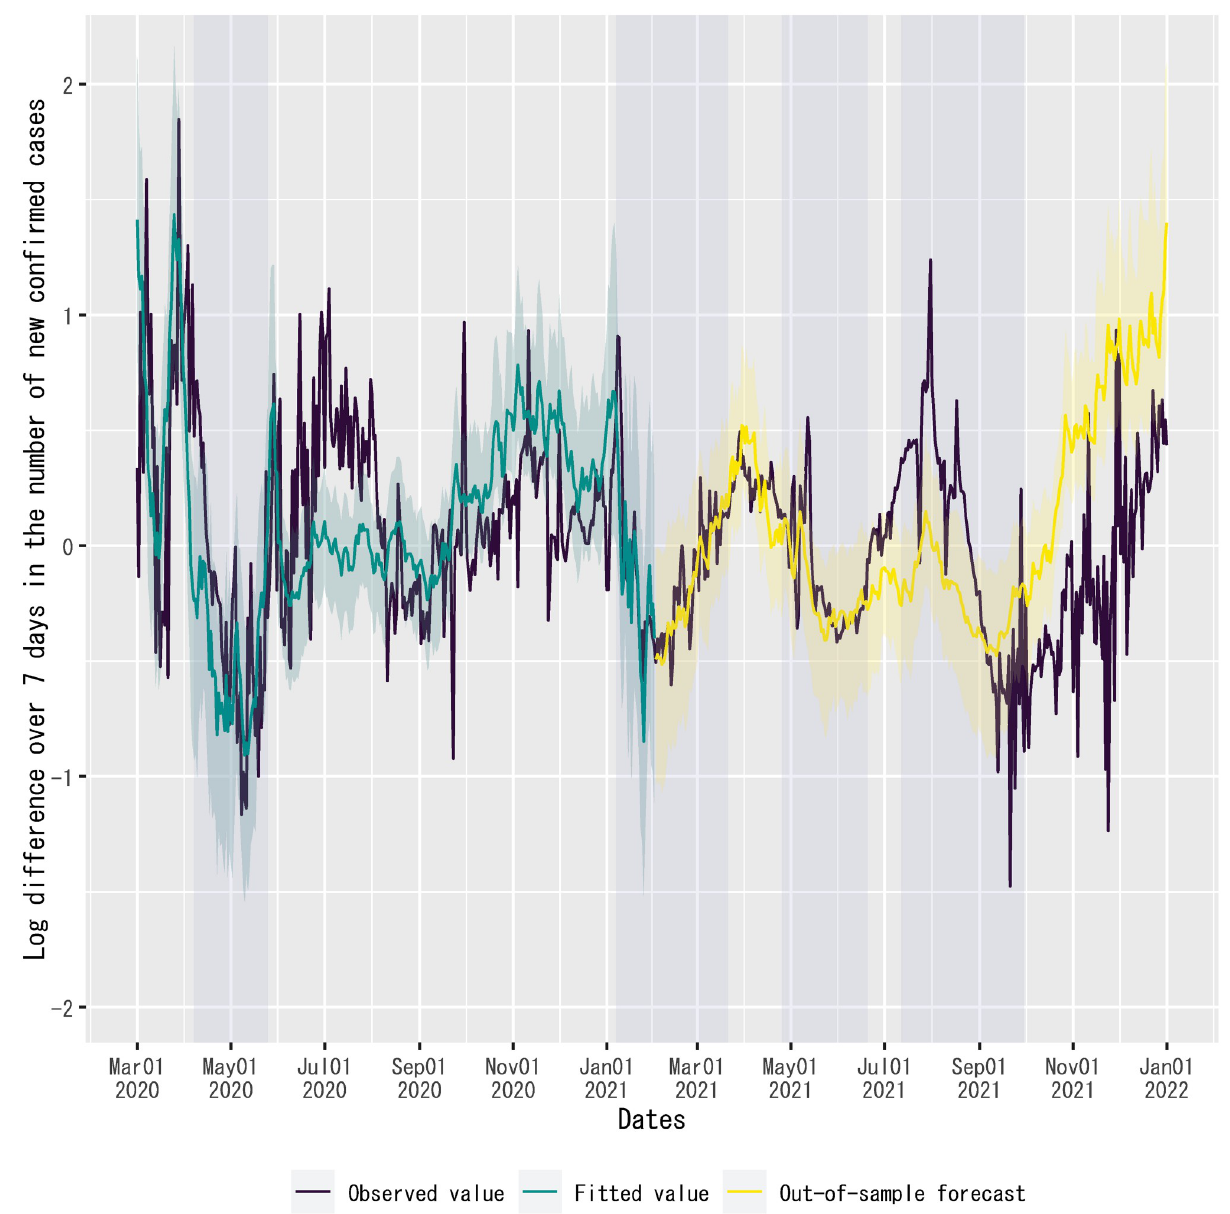
Fig 6. Fitted values and out-of-sample forecasts of the regression. The dependent variable is the log difference over seven days in the number of new confirmed cases of COVID-19 in Japan. For out-of-sample forecasts, the time dummy for the second state of emergency is set to zero without changing the posterior means of regression coefficients. The sample period shown in the figure is from March 1, 2020, to January 1, 2022. For the fitted values and the out-of-sample forecasts, the solid line is the posterior mean and the shadowed area indicates the 95% credible interval on each date. Each shadowed period indicates a state of